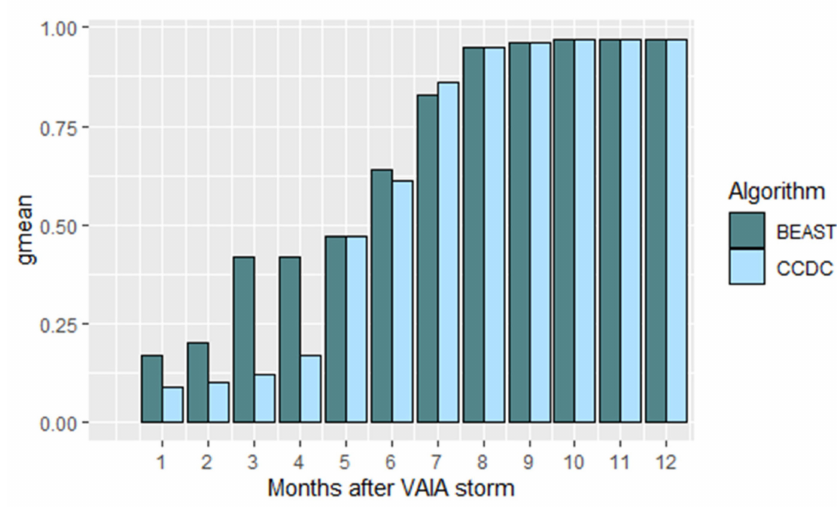
Figure 4. Accuracy estimates based on confusion matrices constructed using the validation dataset and the maps derived by the two algorithms for the 12 months after the storm. The vertical axis represents the accuracy index g mean .